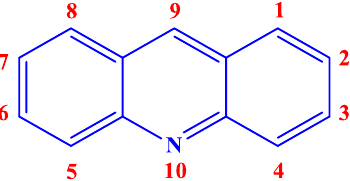
Figure 1. Chemical structure and numeration of